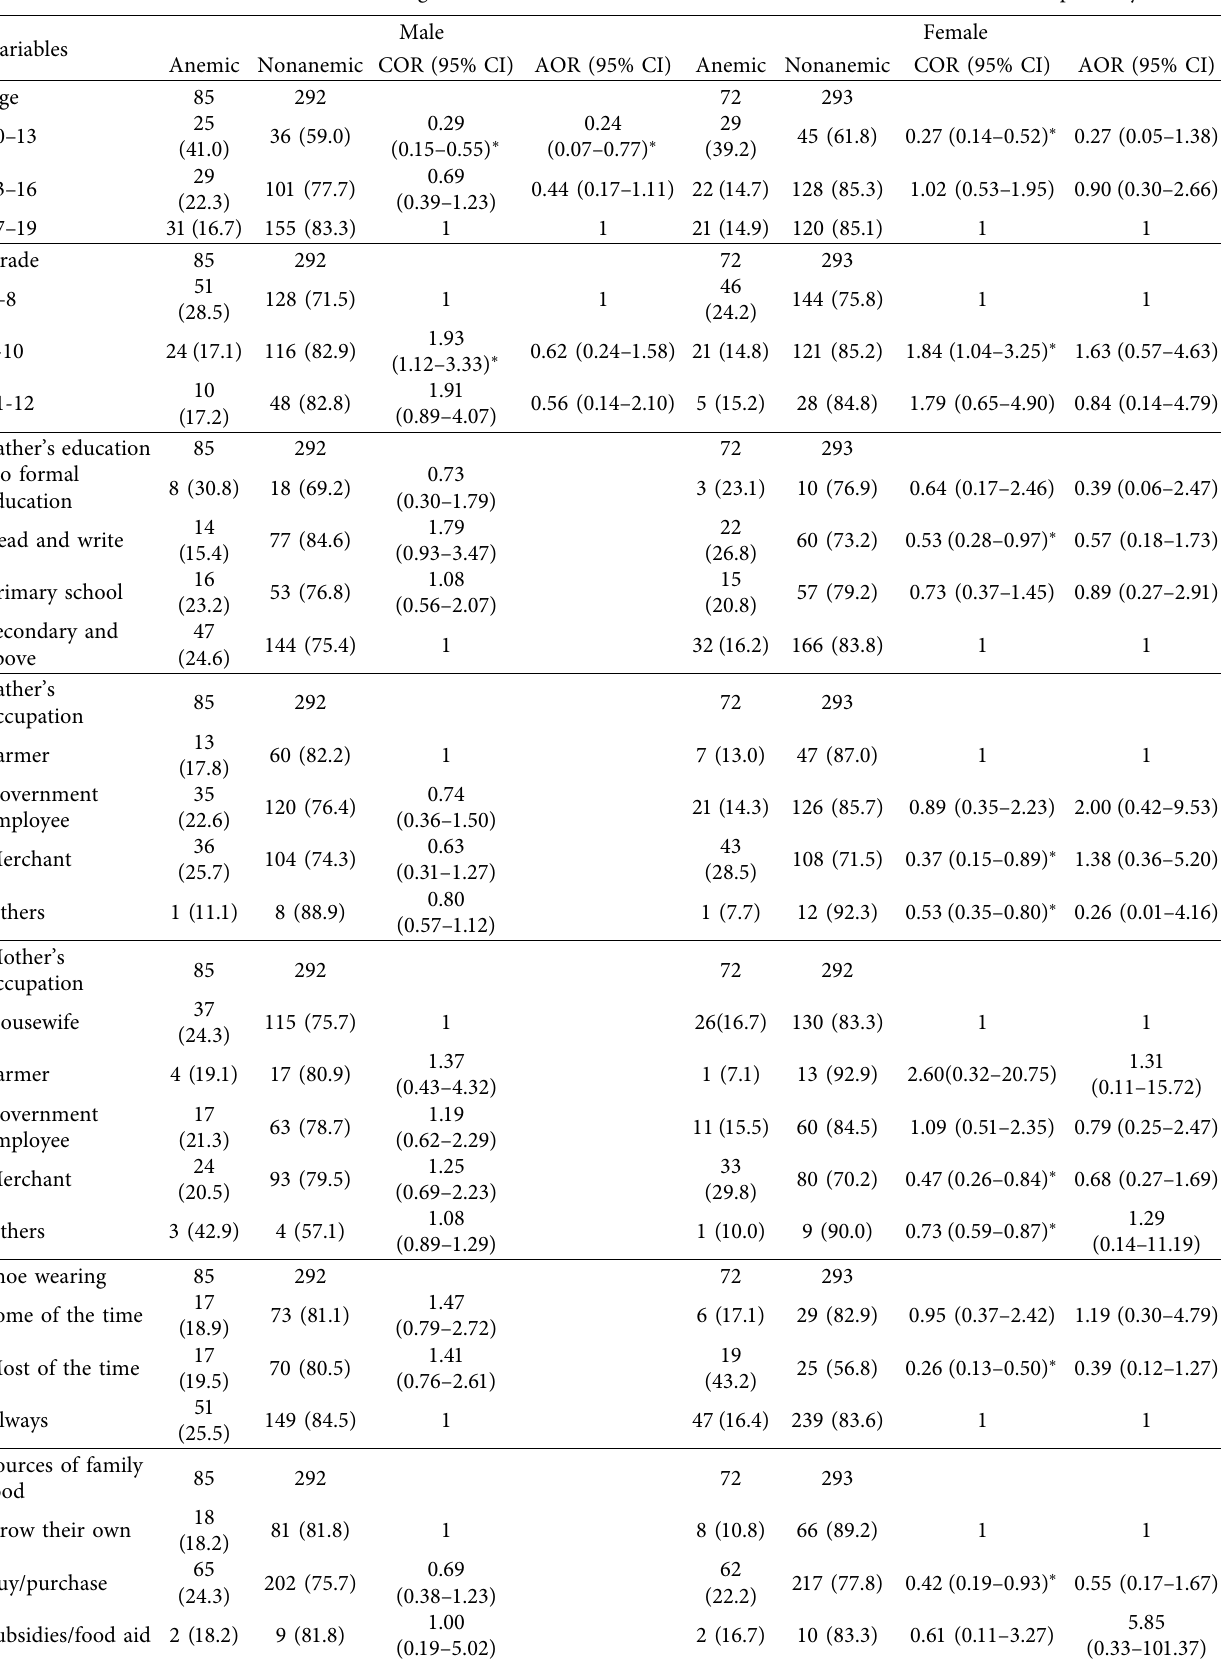
Table 5: Associated factors of anemia among male and female adolescent students in Dilla Town, Southern Ethiopia, May 2018.